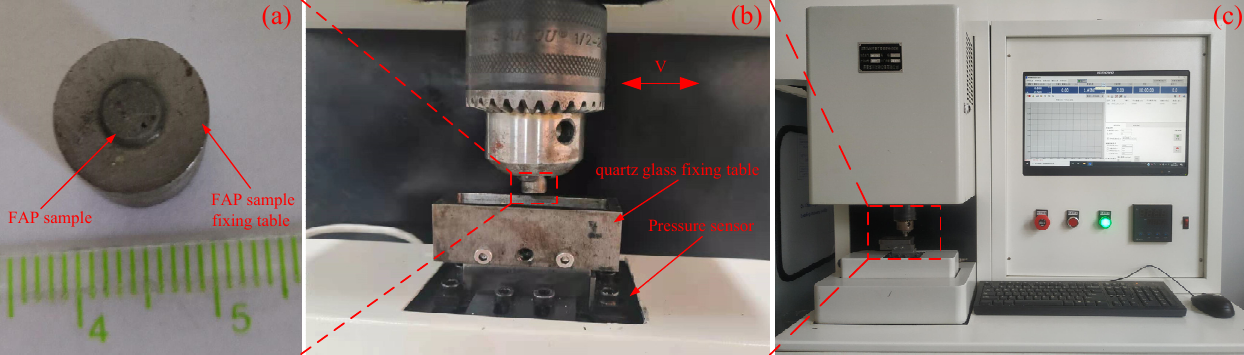
Figure 3. The experimental equipment and partial enlarged view. Note: ( a ) FAP sample; ( b ) local amplification; ( c ) experimental equipment.